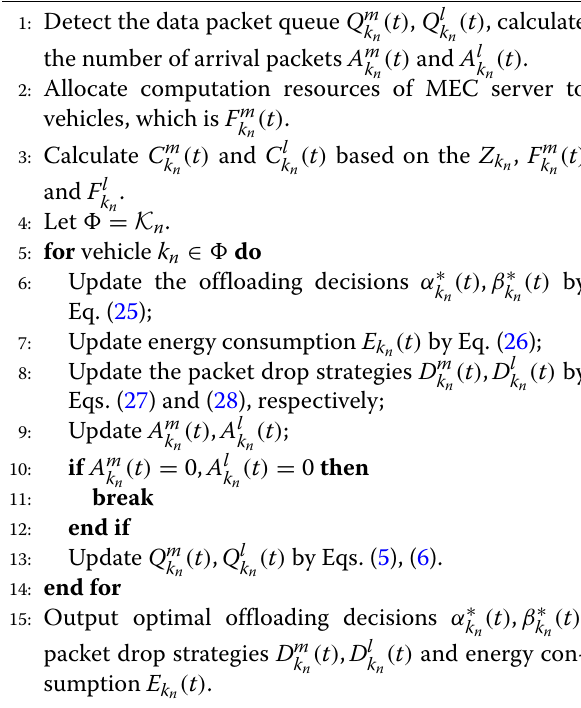
Algorithm 1 Lyapunov-based Dynamic Offloading Deci- sion Algorithm